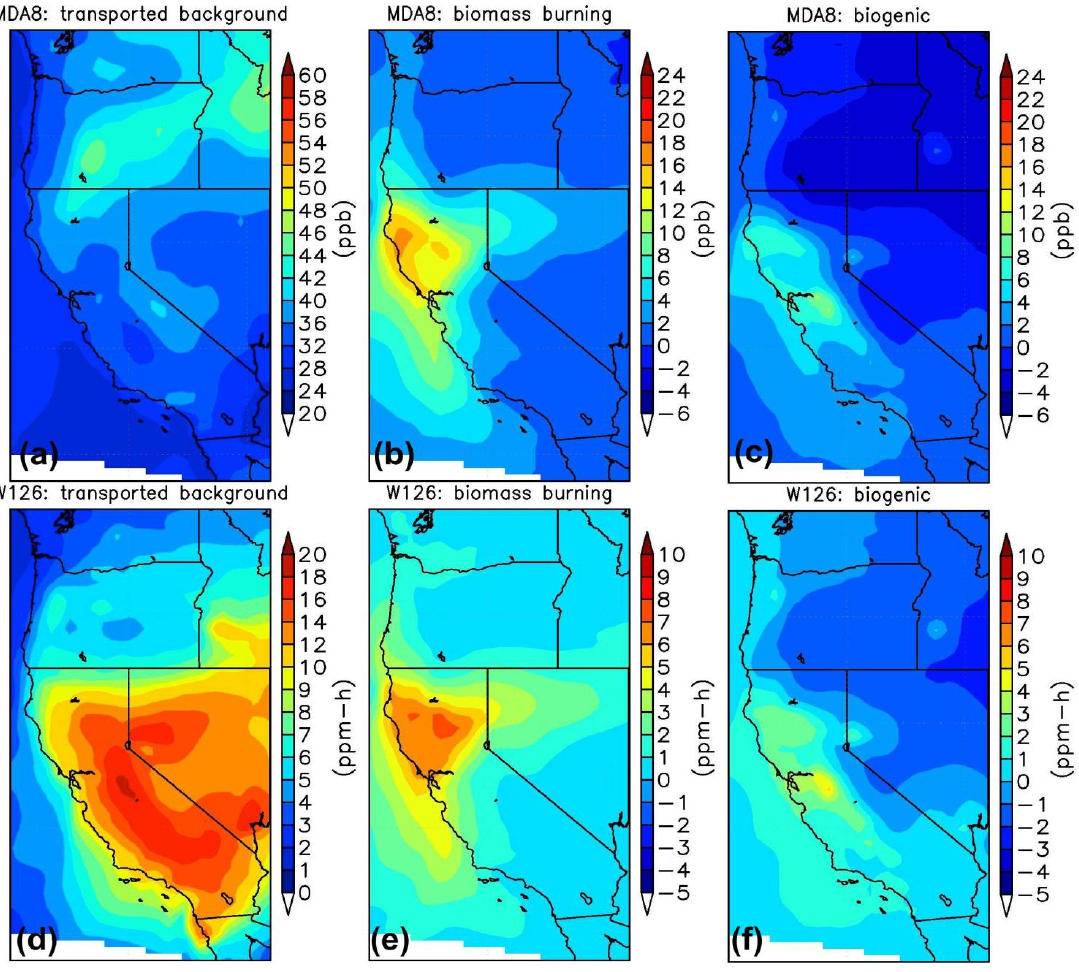
Fig. 4. Surface (a–c) MDA8 and (d–f) W126 contributed from (a,d) transported background based on extrapolation; (b,e) North American biomass burning and (c,f) biogenic emissions. The extrapolation methods to calculate (a) and (d) are described in Sect.